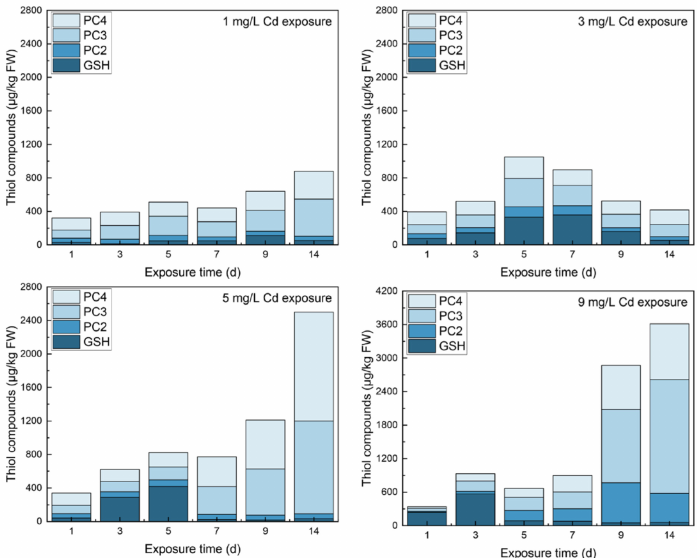
Figure 5. The total thiol in roots under different levels of Cd stress.